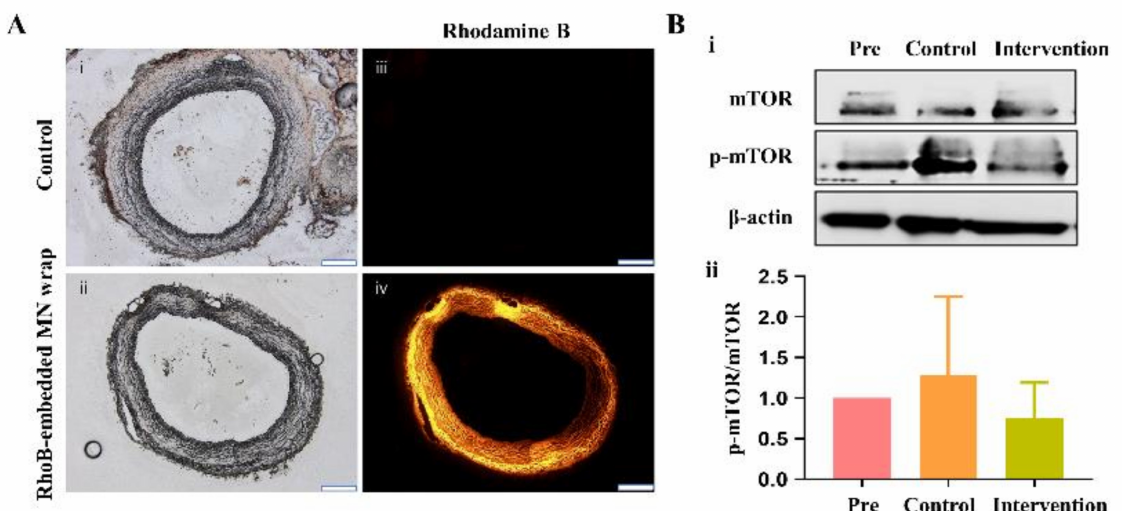
Figure 1. Drug release efficacy using fluorescence analysis and western blot analysis of mTOR expression. ( A ) Fluorescence analysis of internal thoracic artery-vein graft applied with rhodamine B (RhoB)–embedded silk microneedle (MN) wrap; differential interference contrast (DIC) microscopic images of a (i) control vein graft or (ii) vein graft wrapped with RhoB-embedded MN wrap; fluorescent images of a (iii) control vein graft or (iv) vein graft wrapped with RhoB-embedded MN wrap. ( B ) (i) Western blot analysis of mTOR expression before sirolimus-embedded silk MN wrap in the control and intervention groups and (ii) quantitative analysis of mTOR expression before sirolimus- embedded silk MN wrap in the control and intervention groups. Scale bars indicate 200 µ m.